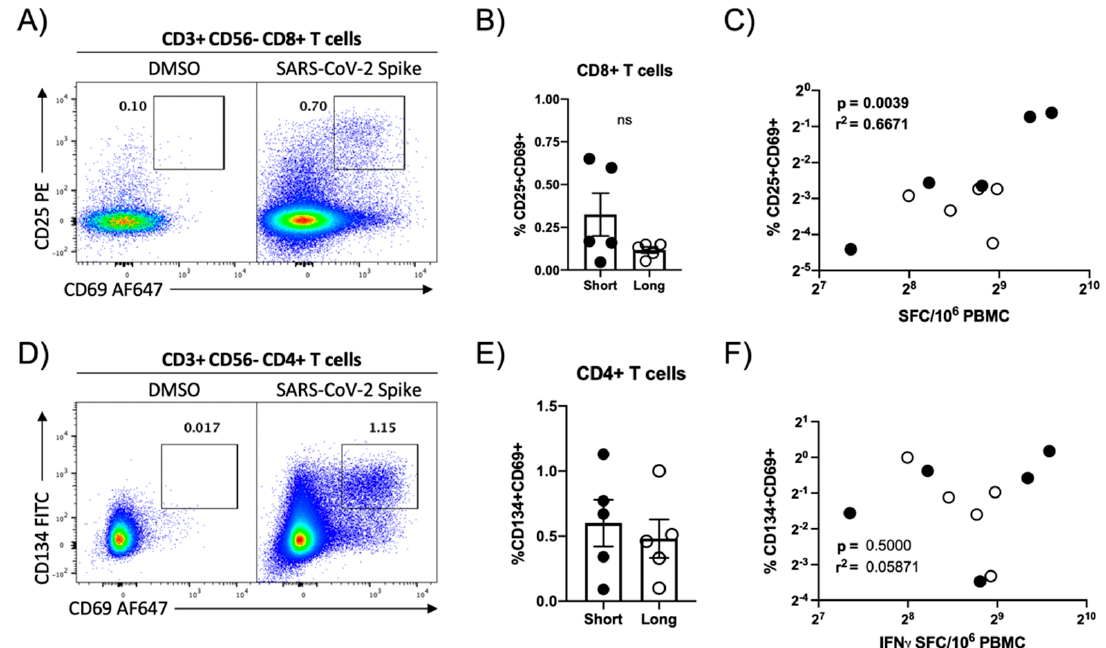
Figure 3. Flow cytometric quantification of SARS-CoV-2 spike protein-specific cellular immunity. ( A ) Representative flow cytometry plot demonstrating CD25 and CD69 upregulation in CD8+ T cells following in vitro SARS-CoV-2 spike protein peptide pool stimulation. ( B ) Magnitude of SARS-CoV-2 spike-specific CD8+ T cell responsiveness in select study participants split by duration of self-reported duration of COVID-19 symptoms. Plotted values are background subtracted from a total of 10 subjects. ( C ) Correlation analysis of SARS-CoV-2-specific cellular immunity as defined by CD8+ flow cytometry and IFN- γ ELISPOT. r 2 and p value calculated by 2-tailed Pearson Correlation test. ( D ) Representative flow cytometry plot demonstrating CD134 and CD69 upregulation in CD4+ T cells following SARS-CoV-2 spike protein peptide pool stimulation. ( E ) Magnitude of SARS-CoV-2 spike-specific CD4+ T cell immunity in select study participants split by duration of self-reported duration of COVID-19 symptoms. Plotted values are background subtracted from a total of 10 subjects. (F ) Correlation analysis of SARS-CoV-2-specific cellular immunity as defined by CD4+ flow cytometry and IFN- γ ELISPOT. r 2 and p value calculated by 2-tailed Pearson correlation test.